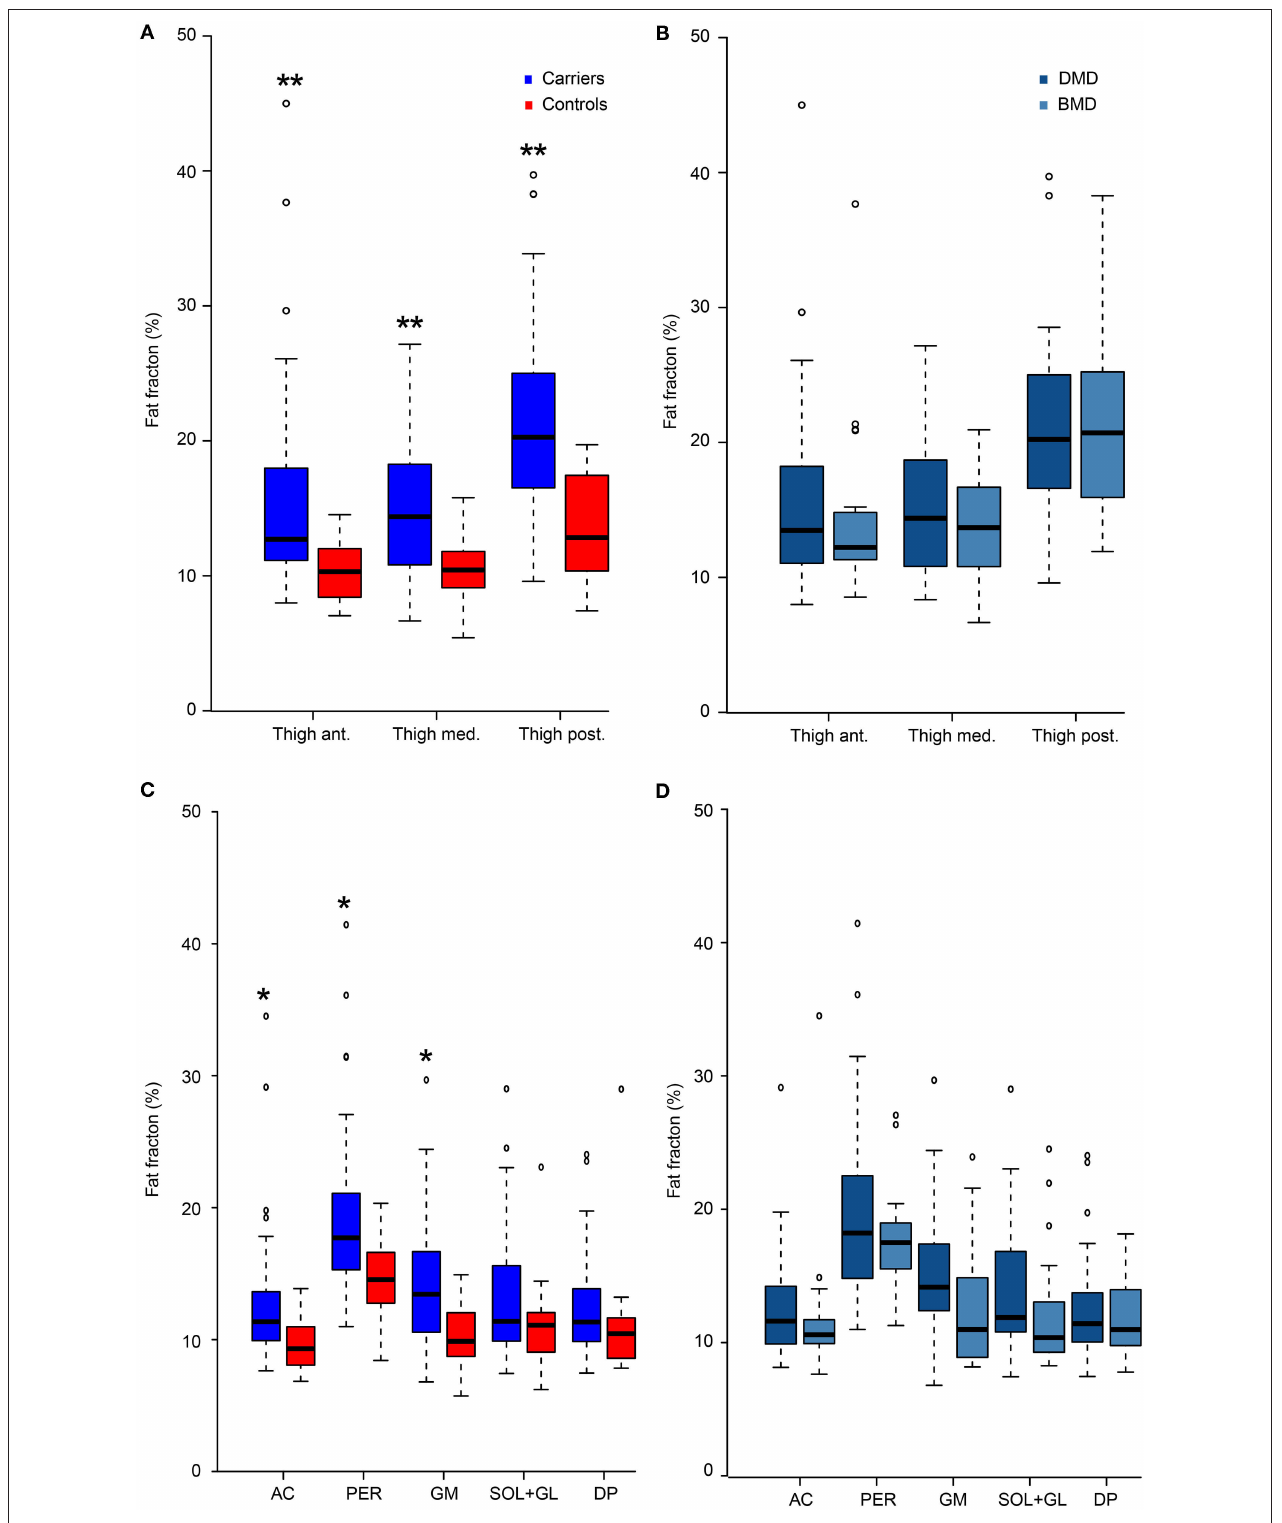
FIGURE 4 | Fat fraction. Fat fractions in women with pathogenic variants in DMD compared to healthy women (controls) in thigh (A) and calf muscles (C) , and comparison of fat fractions in women with variants predicted to result in Duchenne muscular dystrophy (DMD) and Becker muscular dystrophy (BMD) in thigh (B) and calf (D) muscles. Presented as median value and four quartiles. Ant, anterior thigh muscles; Med, medial thigh muscles; Post, posterior thigh muscles; AC, anterior calf compartment; PER, peroneal muscle compartment; GM, medial gastrocnemius muscle; SOL + GL, soleus and lateral gastrocnemius muscle; DP, deep posterior calf muscles. * p < 0.05 and ** p < 0.001 vs.